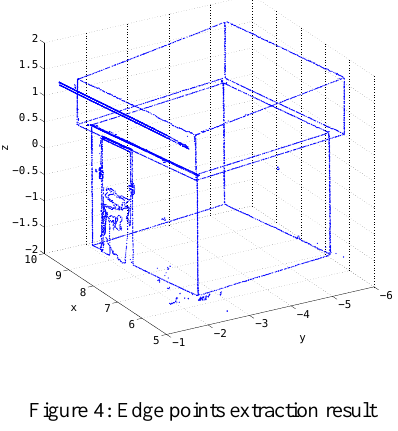
Figure 4: Edge points extraction result 3 INFRARED IMAGE EDGE EXTRACTION